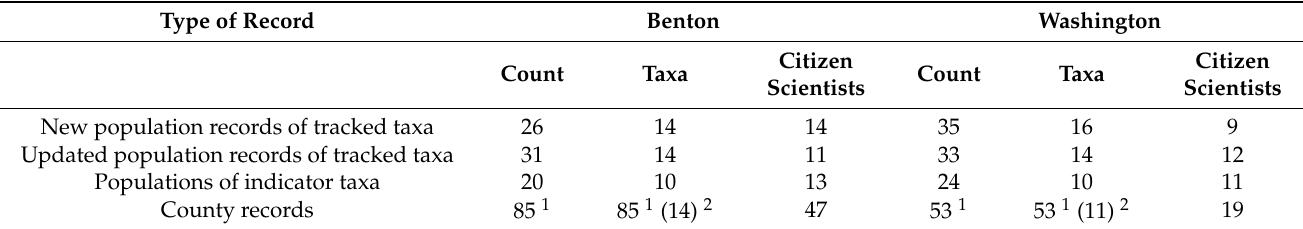
Table 2. Citizen scientist contributions to the County Natural Heritage Inventory (CNHI) report for Benton and Washington Counties, Arkansas, USA. Population records of tracked taxa will be incorporated into the Natural Heritage Database, which includes creating records for new populations and updating records of previously known populations [48]. Indicator taxa have a high conservation value and indicate high-quality habitats. County records are taxa not previously known from a county